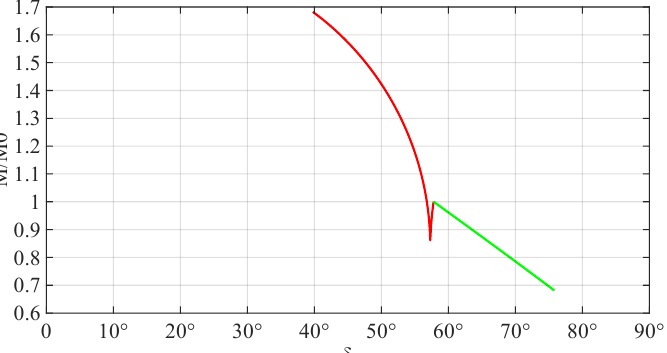
Figure 12. The obstacle height h is 10 mm. Comparison of torque under transformable state C 1 and C 2 M / M 0 (Red: C 1 ; Green: C 2 ).